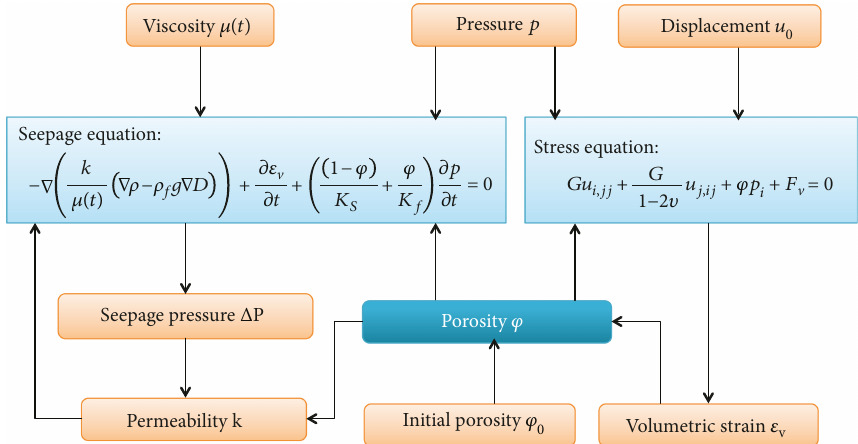
Figure 11: Schematic of numerical analysis.